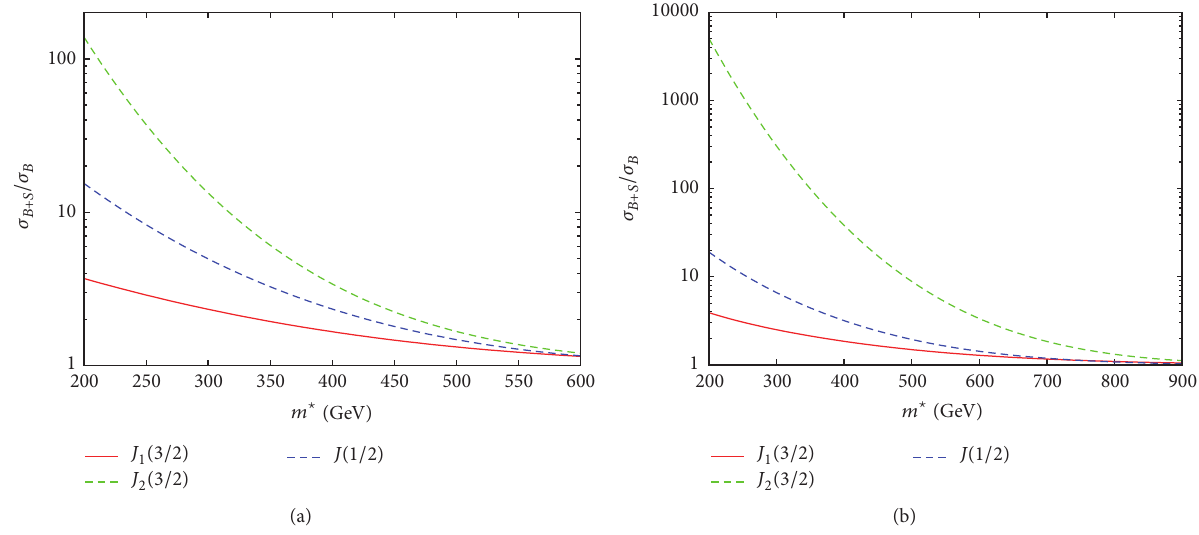
Figure 7: 𝜎 𝐵+𝑆 /𝜎 𝐵 − 𝑚 ⋆ plots for √𝑠 = 1.3 TeV (a) and √𝑠 = 1.98 TeV (b). ( 𝑓 = −𝑓 󸀠 = 1 for the spin-1/2 and 𝑐 𝑖𝑉 = 𝑐 𝑖𝐴 = 0.5 ( 𝑖 = 1, 2 ) for the spin-3/2.)